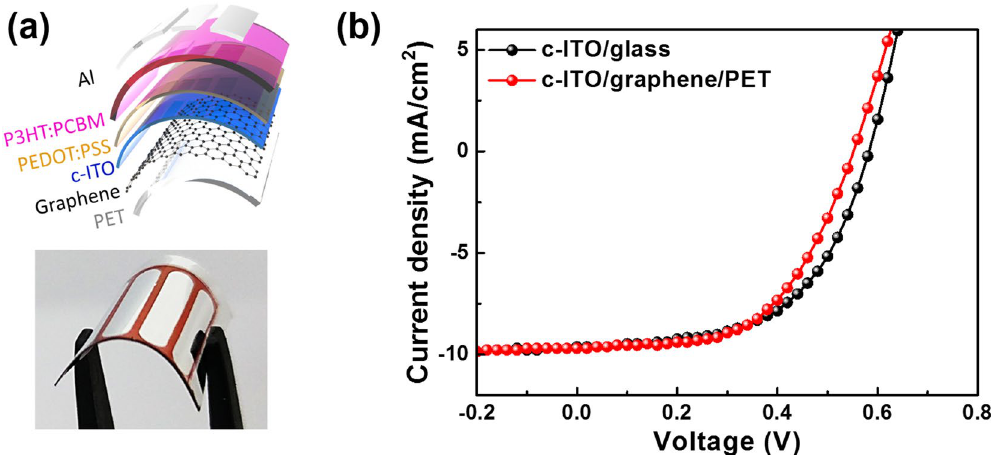
Figure 6. ( a ) Schematic illustration of the device structure and digital image of the PSC prepared with a graphene-based c-ITO anode on a PET substrate. ( b ) Current density–voltage ( J – V ) curves of the PSCs with c-ITO/graphene/PET and c-ITO/glass as the anode